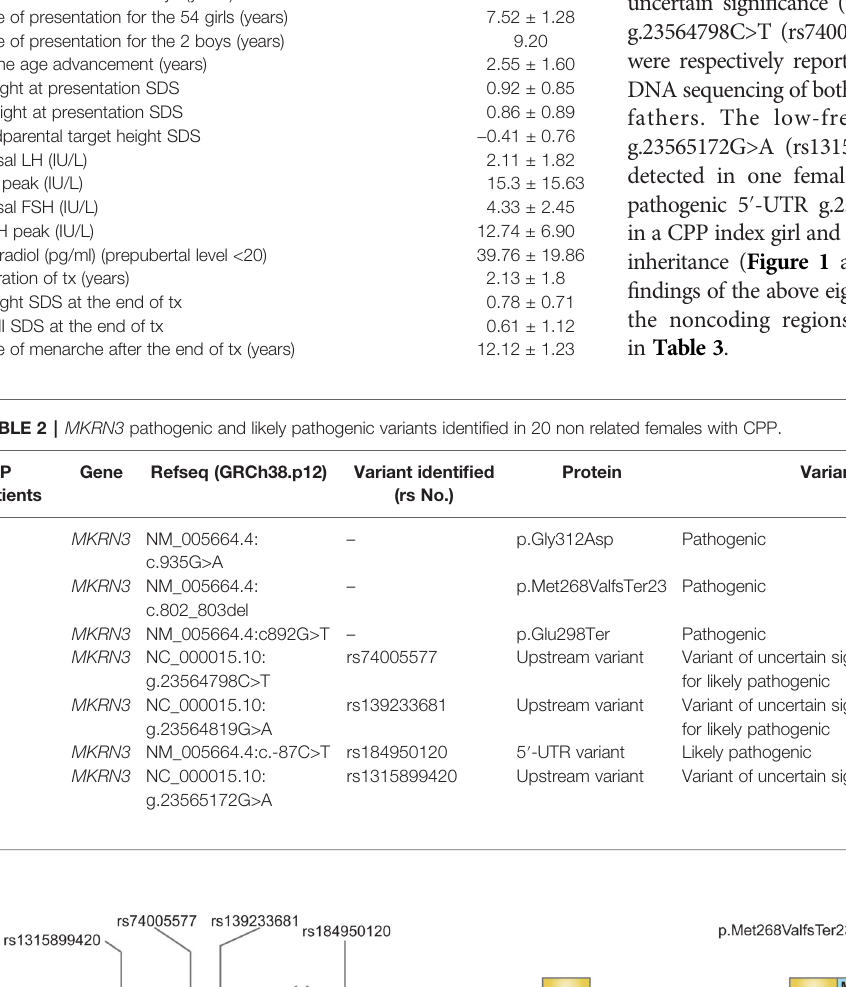
Age of onset for the 54 girls (years)